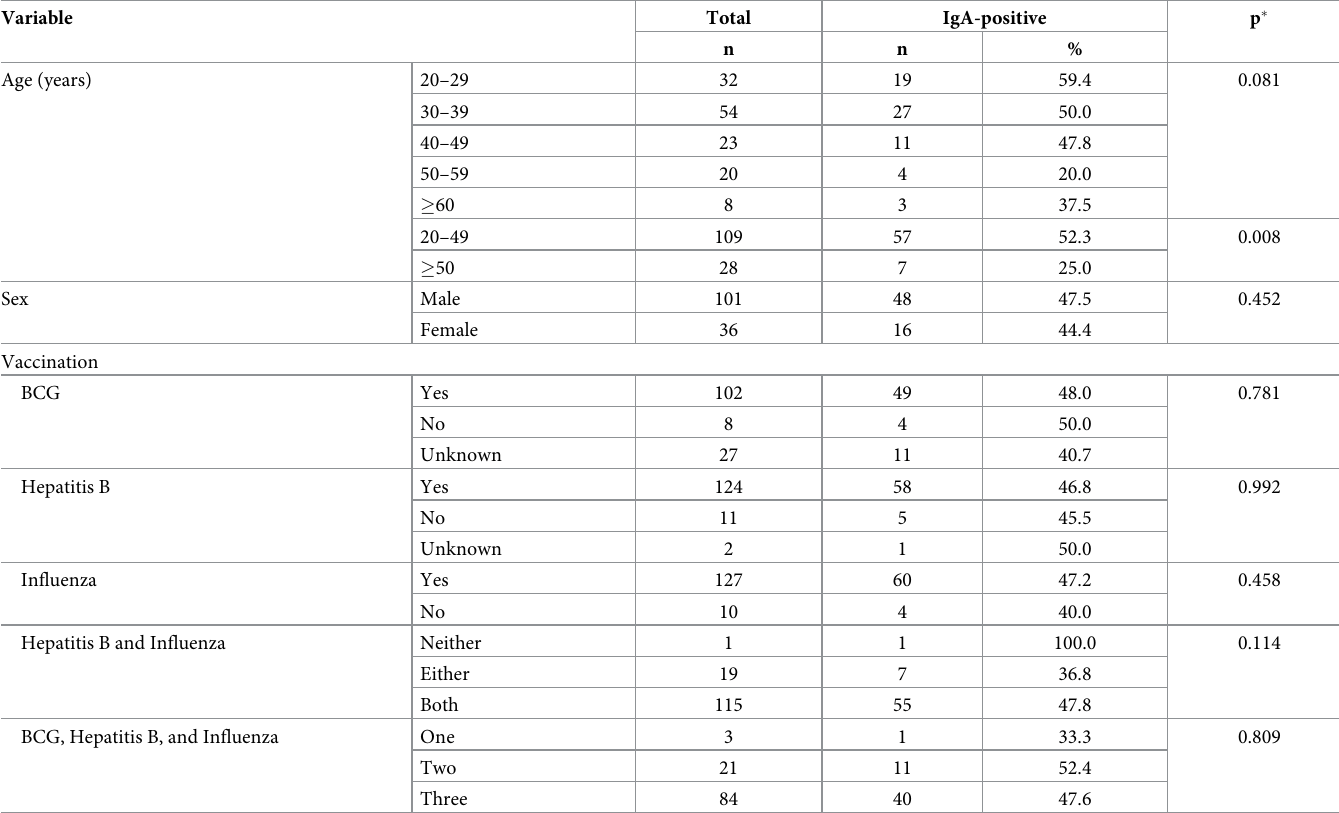
Table 1. Associations of CrSA positivity with age, sex, and vaccination